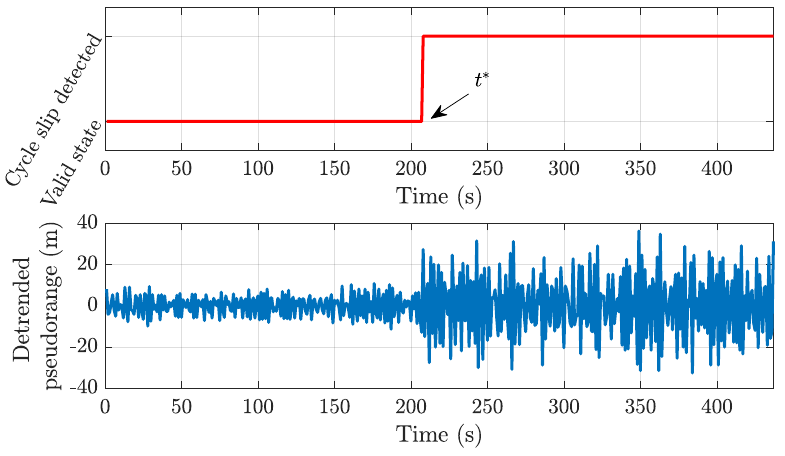
Figure 10. Effect of cycle slips in a controlled environment (PRN 23).